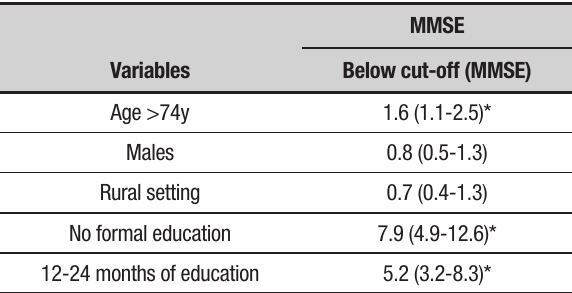
Table 2. Factors (age, sex, setting and level of formal education) as- sociated with scoring below cognitive cut-off (MMSE). Odds ratio, 95% confidence intervals in